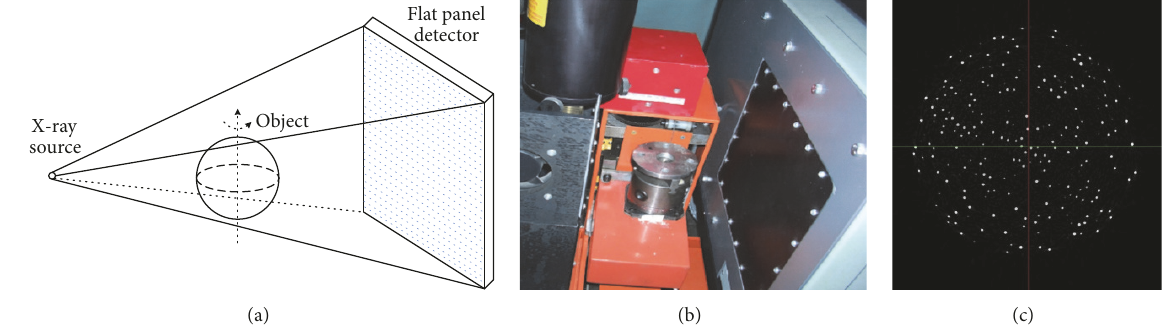
Figure 3: (a) Scheme of 3D cone-beam CT, (b) facility, and (c) a tomographic image of a spherical fuel element.